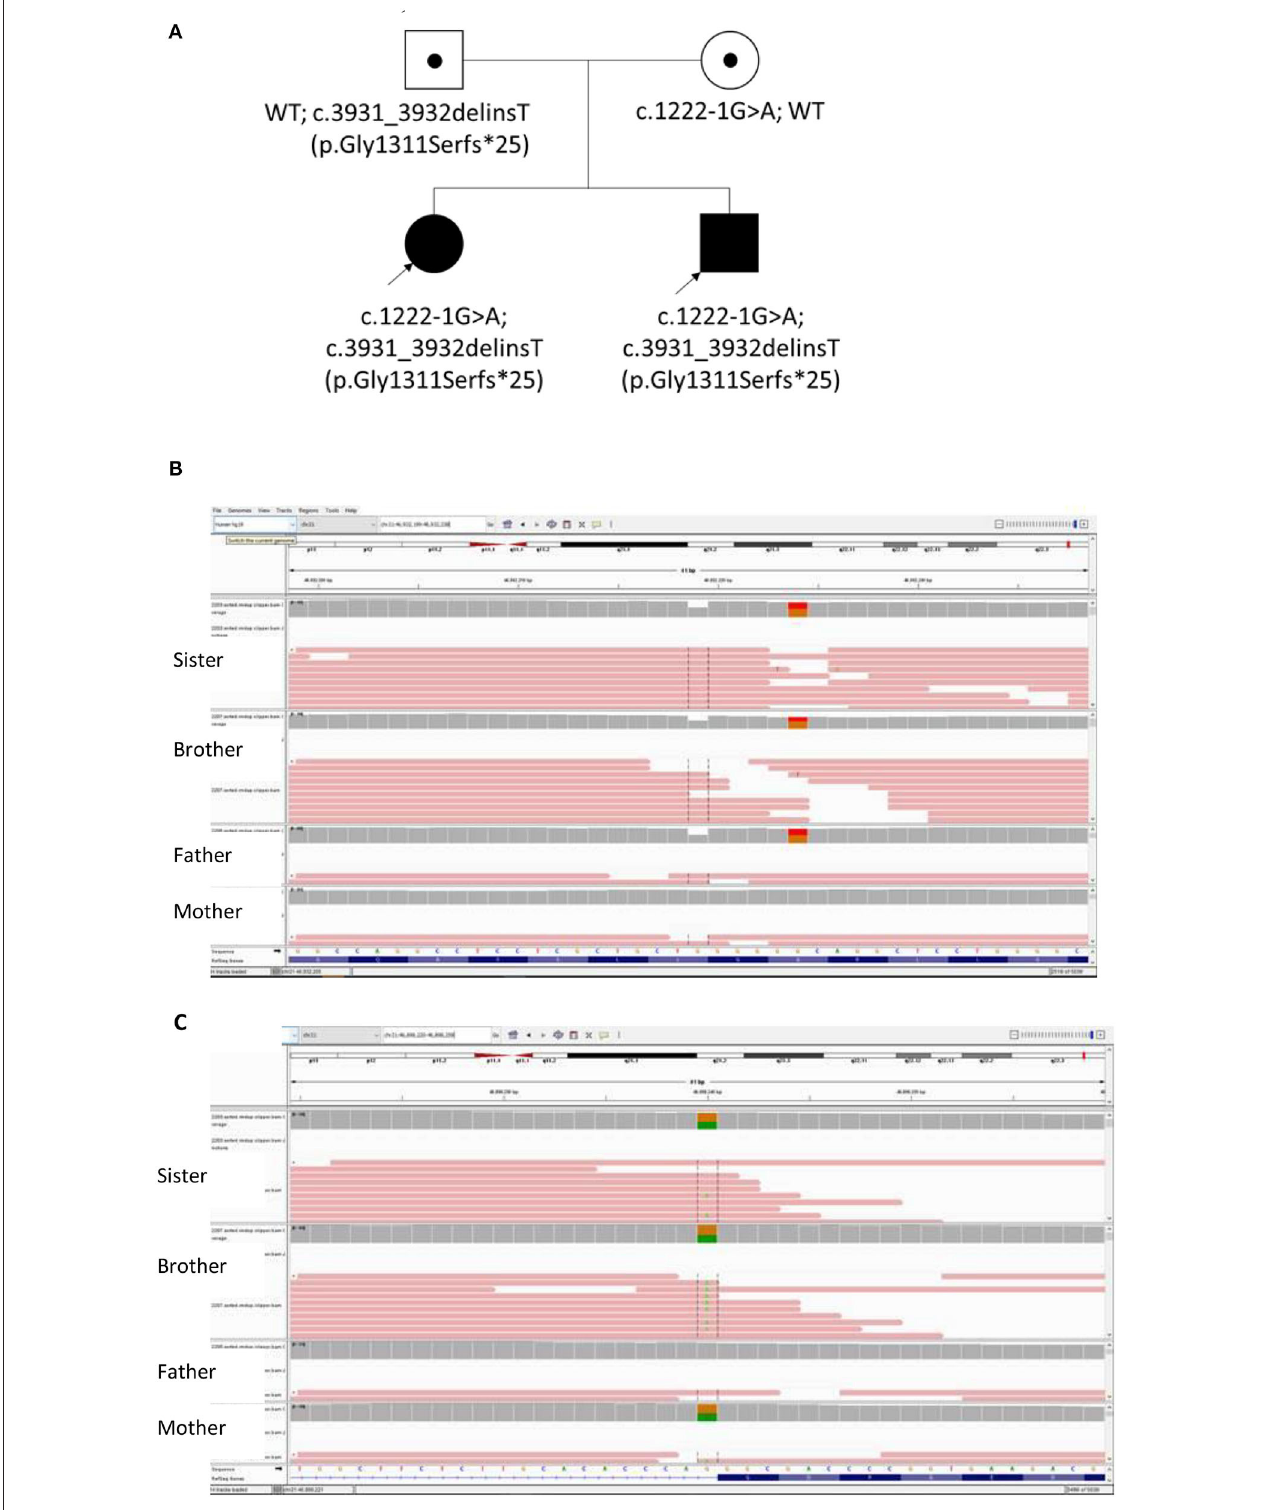
FIGURE 2 | (A) The Pedigree of this Chinese family with biallelic changes in the COL18A1 gene; (B) Integrated Genomics Viewer (IGV) screenshot of variant c.3931_3932delinsT inherited from father; (C) IGV screenshot of Variant 1222-1G > A inherited from mother.